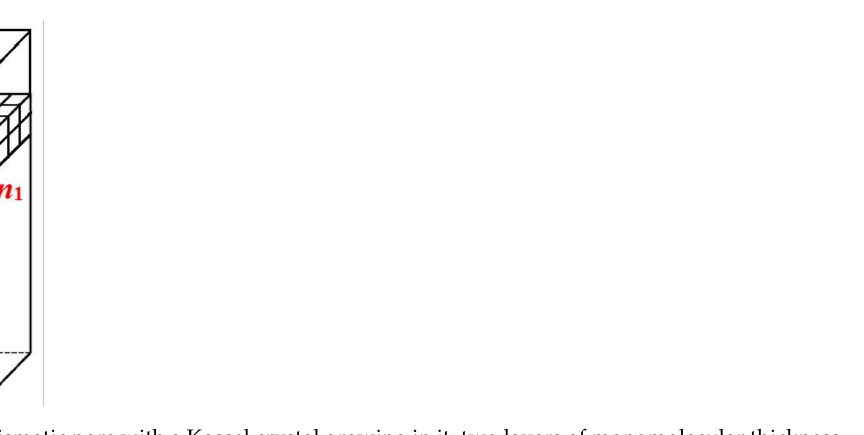
Figure 1. A prismatic pore with a Kossel crystal growing in it; two layers of monomolecular thickness are shown. The numbers of molecules at the edges of the Kossel crystal are denoted by n and n 1 . The growth direction of the crystal is shown by a blue arrow.